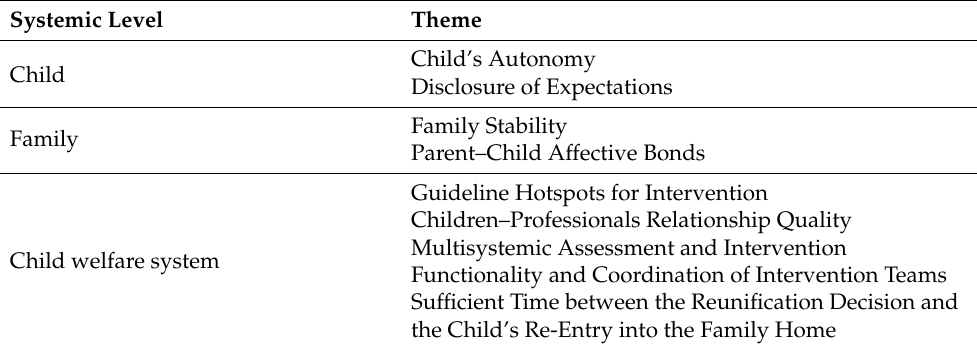
Table 1. Key issues that foster the success of family